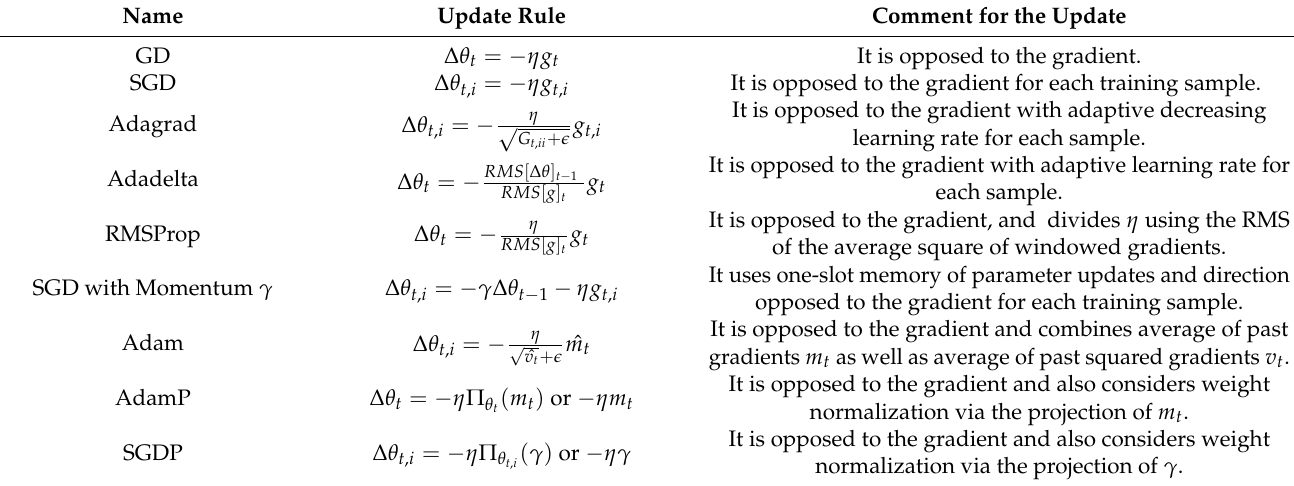
Table 1. Update rules for several gradient descent